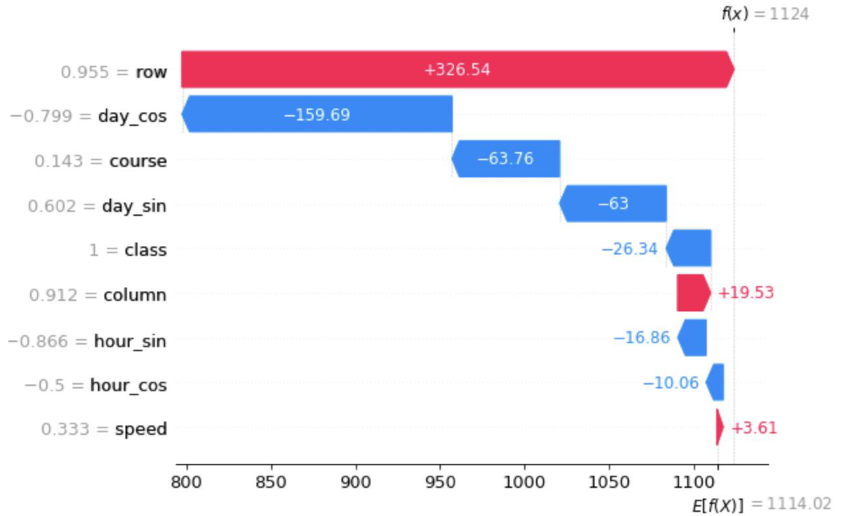
Figure 8. The contribution of each input feature to build the output predicted by KNN-WD for ship 26.